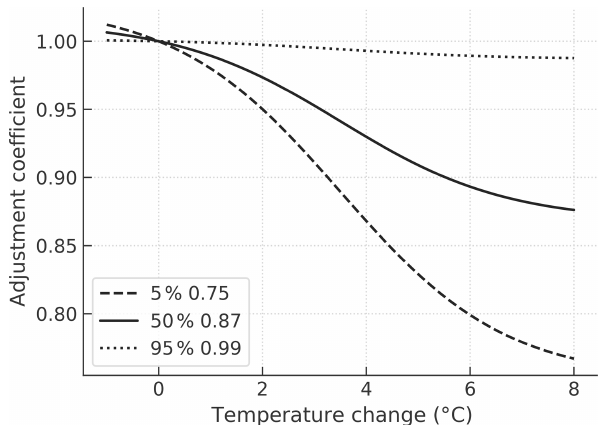
Figure 4. Adjustment coefficient as a function of surface tempera- ture change to multiply the time constants for the decay of wood and soil organic matter. The three curves are functions corresponding to the 5th, 50th, and 95th percentiles of the Prior ensemble, which is described in Sect. 3.1, with different asymptotic minimum values, as described in the legend. The temperature at which a curve has the maximum gradient is fixed at 3.5 ◦